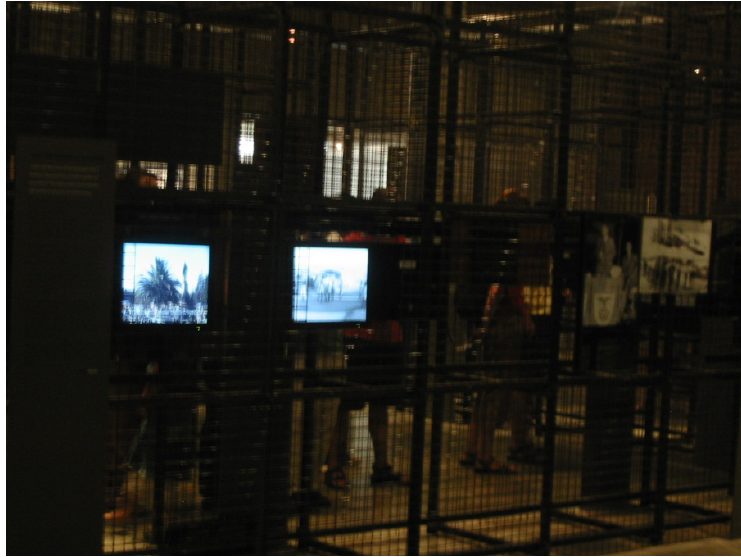
Figure 14. ‘Maze’ of open cages with audio-visual displays, Apartheid Museum, Johannesburg (author’s